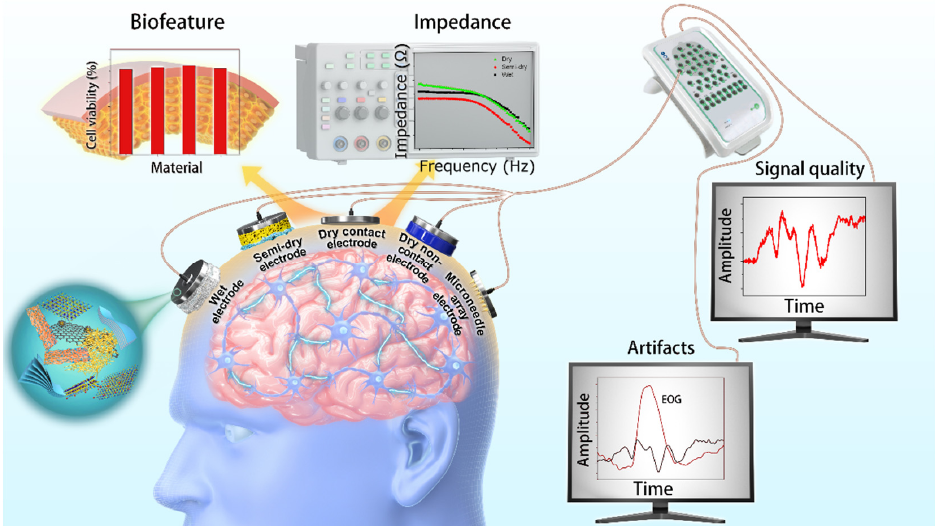
Figure 1. Illustration of various EEG electrodes in configuration, features, and